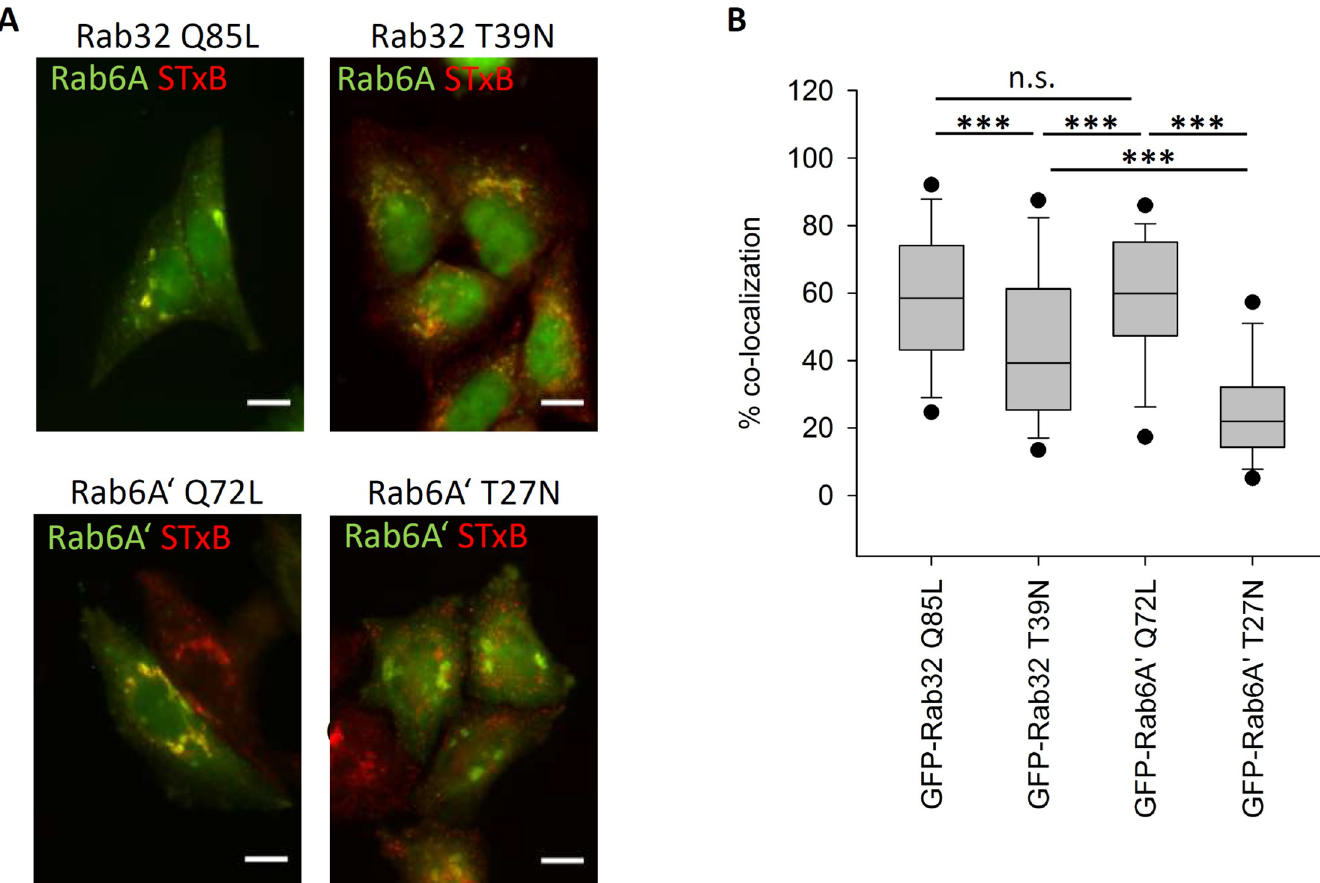
Fig 4. Rab32 influence on retromer mediated transport of Shiga toxin B. (A) HeLa cells transfected with either GFP-Rab32 Q85L, GFP-Rab32 T39N (upper row), GFP-Rab6A’ Q72L or GFP-Rab6A’ T27N (lower row). 24 hours later cells were incubated with STxB-cy3 and pulse-chased for 60 minutes, followed by fixation in 4% PFA. Rab32-expressing cells were additionally stained by immunofluorescent labeling of Rab6A. (blue) to have a comparable Golgi marker to the GFP-Rab6A’ transfected cells. The Rab6A/A’ channels were depicted in green, STxB-cy3 in red. STxB co-localizing with the Golgi apparatus appears in yellow. GFP-Rab32 constructs are not visible. Scalebar = 10 μ m (B) Quantification of STxB transport rates. Endogenous Rab6A or GFP-Rab6A’ was used to determine the localization of the Golgi apparatus. Transport rate is given as % co-localization of STxB with the Golgi apparatus. A lower % co-localization indicates a reduced rate of STxB transport.